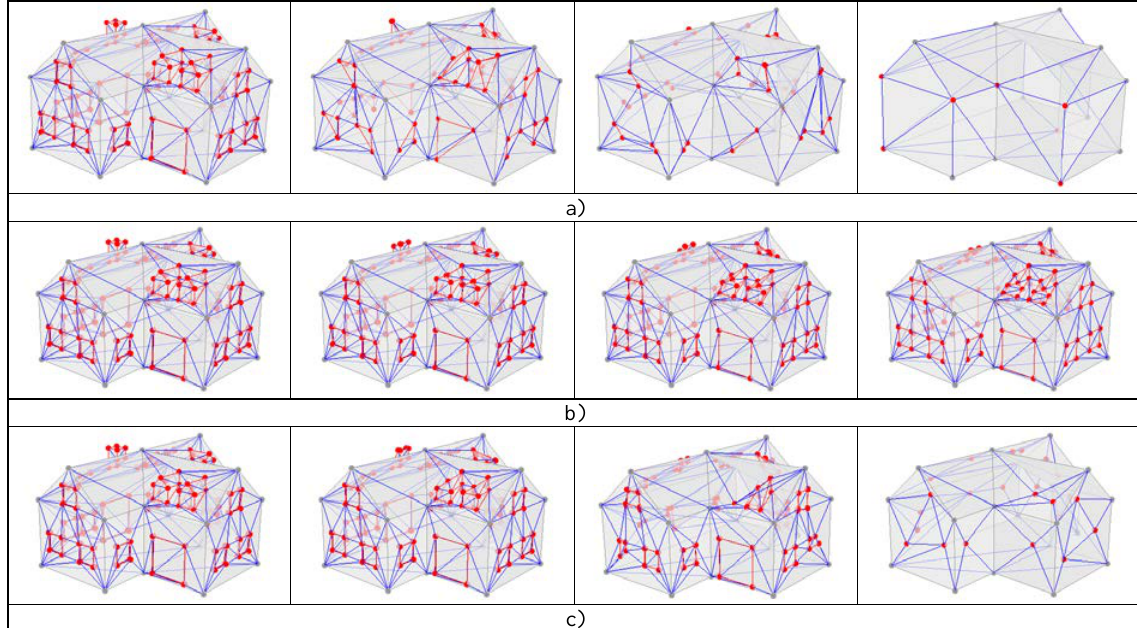
Figure 5. Transformation of a building model with semantic components by a) Shortest Edge First, b) Push Plane, c) Sweep